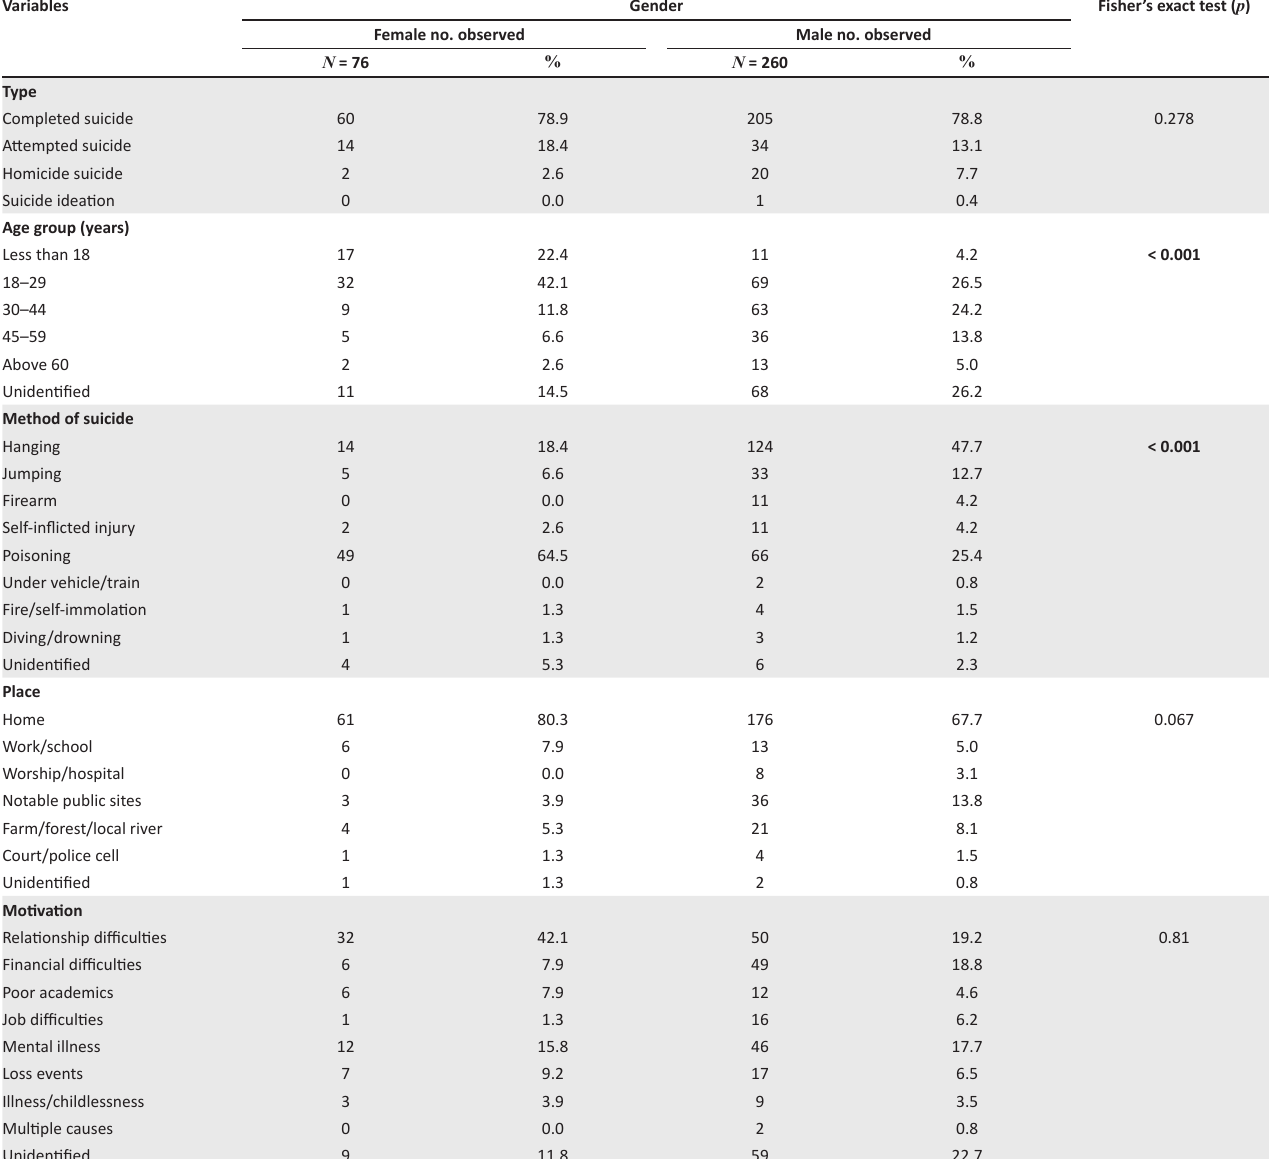
TABLE 3: Gender and type of suicide events, age groups, reported method, place and motivation.